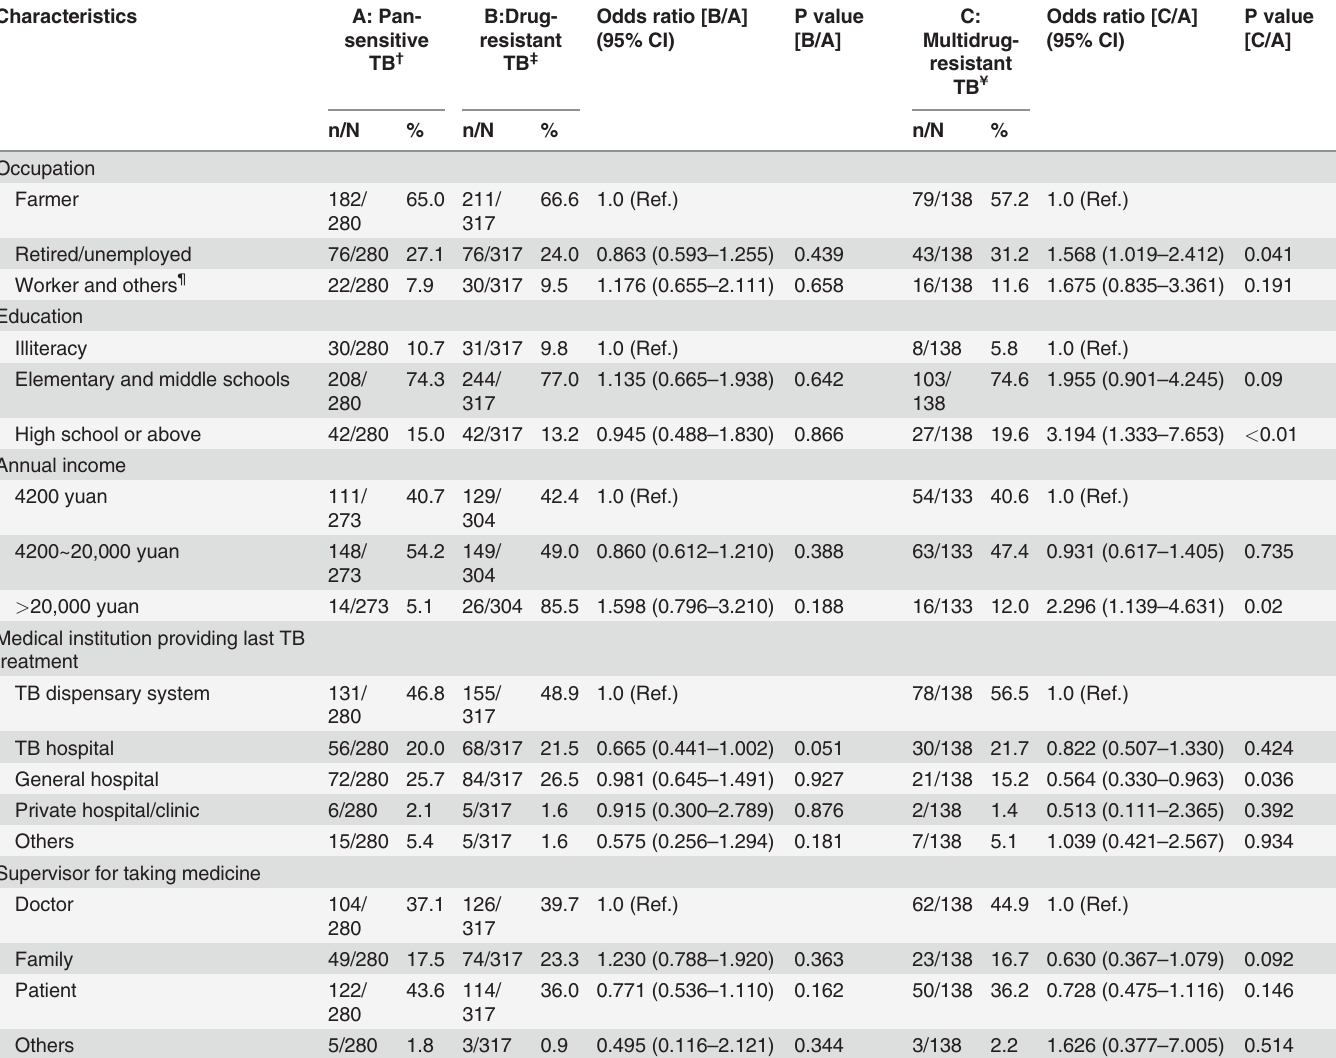
Table 2. Univariate analysis of risk factors for drug-resistant tuberculosis (TB) in re-treated TB cases * .